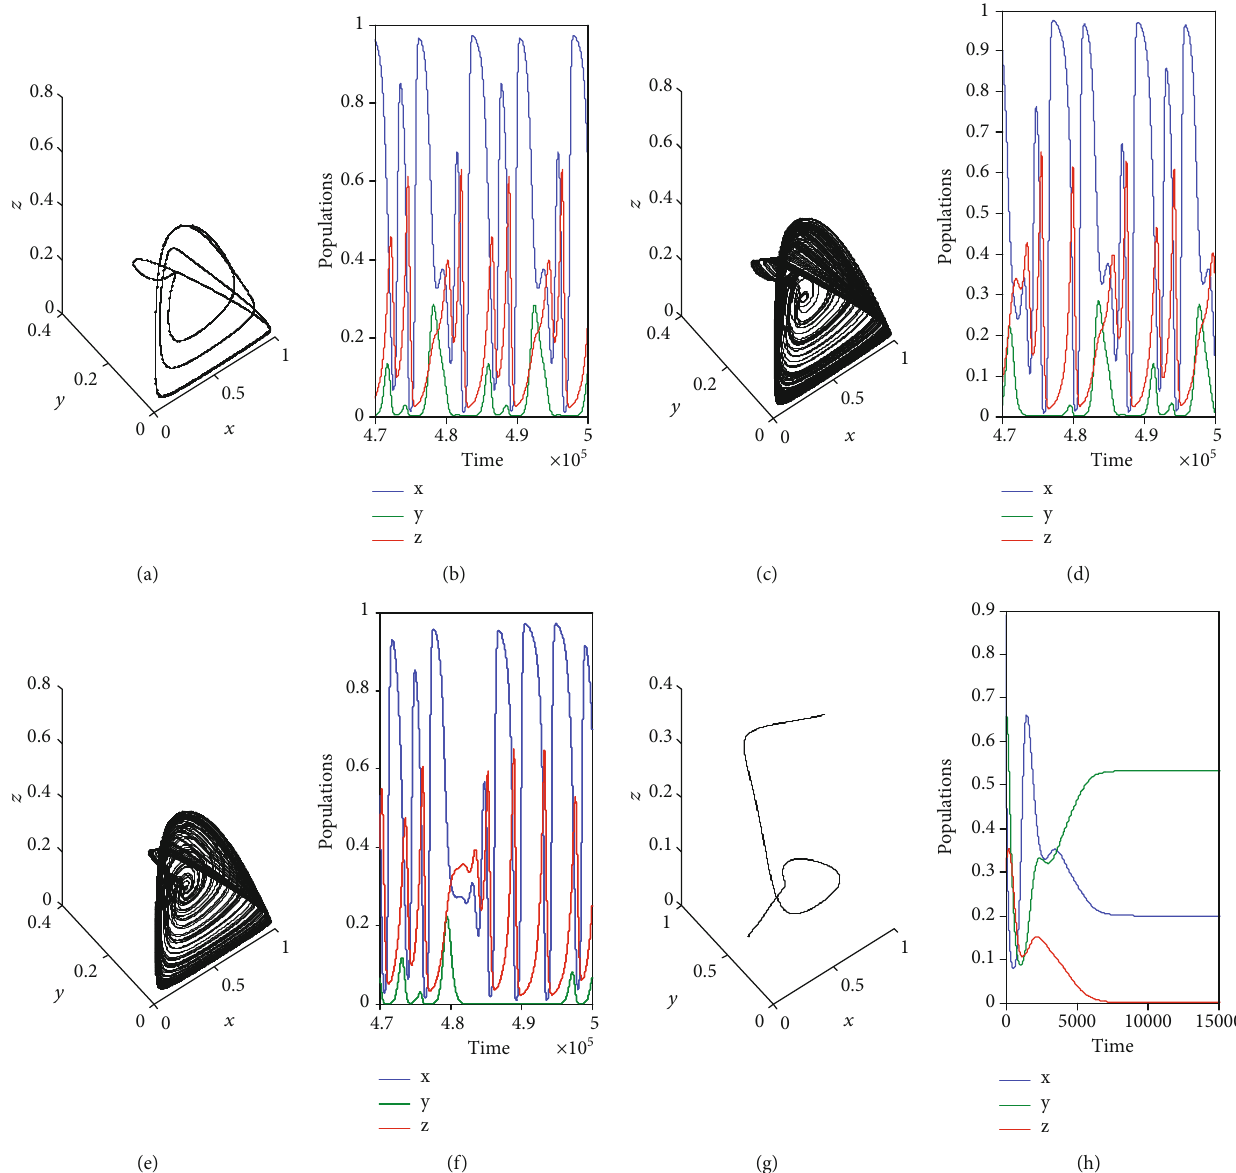
= 0 : 024 . (b) Time series of attractor + where m